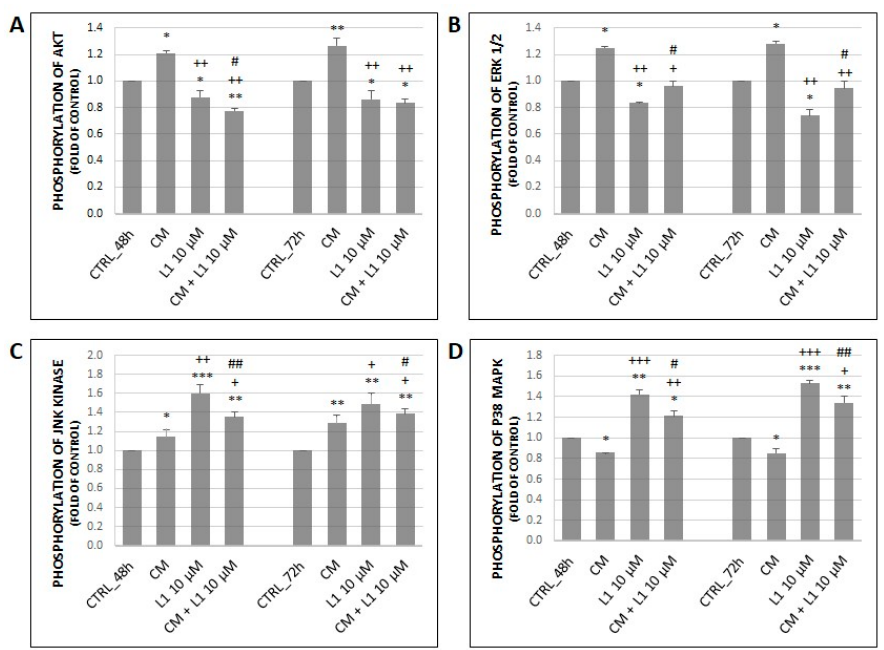
Figure 9. Changes in phosphorylation of Akt ( A ) and MAPK related proteins including Erk1/2 ( B ), JNK ( C ), and p38 ( D ) after 48 h and 72 h of CM from BJ-5ta cells and L1 treatment. Representative data obtained by three independent experiments using flow cytometry. CM—onditioned medium.